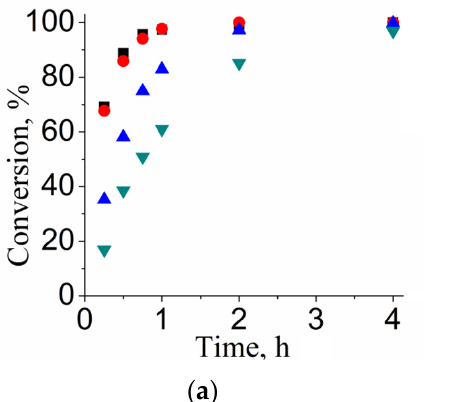
served in all cases due to the sequential reactions of their cleavage and oligomerization.